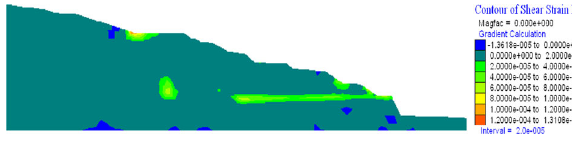
Fig. 18 Cloud chart of shear strain rate of slope in section P-2